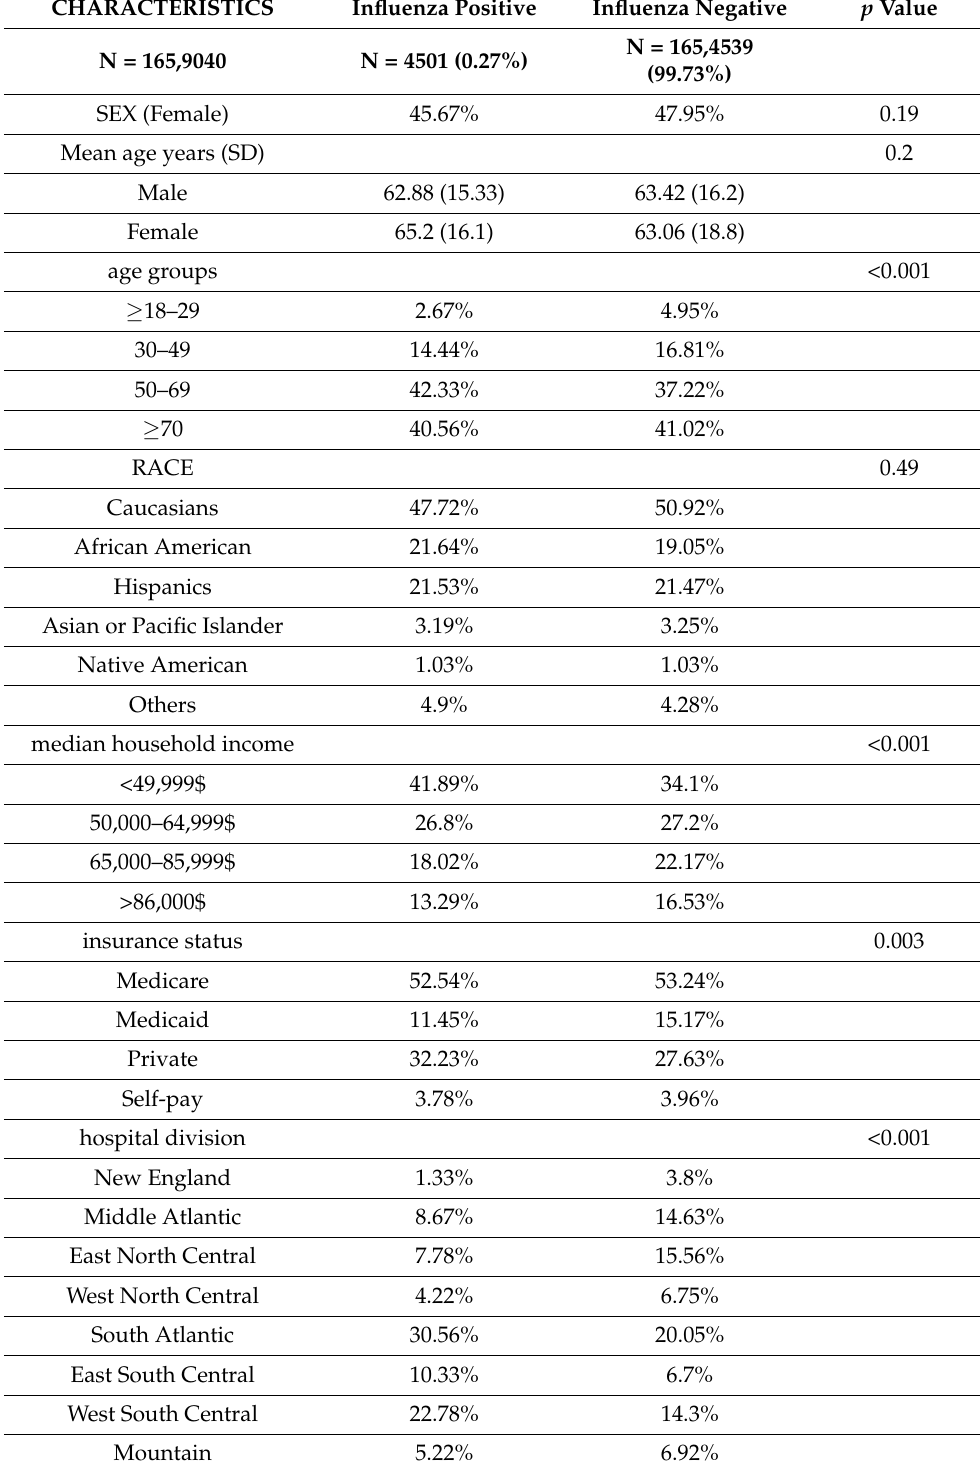
Table 1. Influenza and COVID-19 unmatched patient-level characteristics. SD = Standard devi- ation, CAD = Coronary Artery disease, CHF = Congestive heart failure, HTN = Hypertension, DM = Diabetes Mellitus, AKI – Acute kidney injury, HD = Hemodialysis. CHARACTERISTICS Influenza